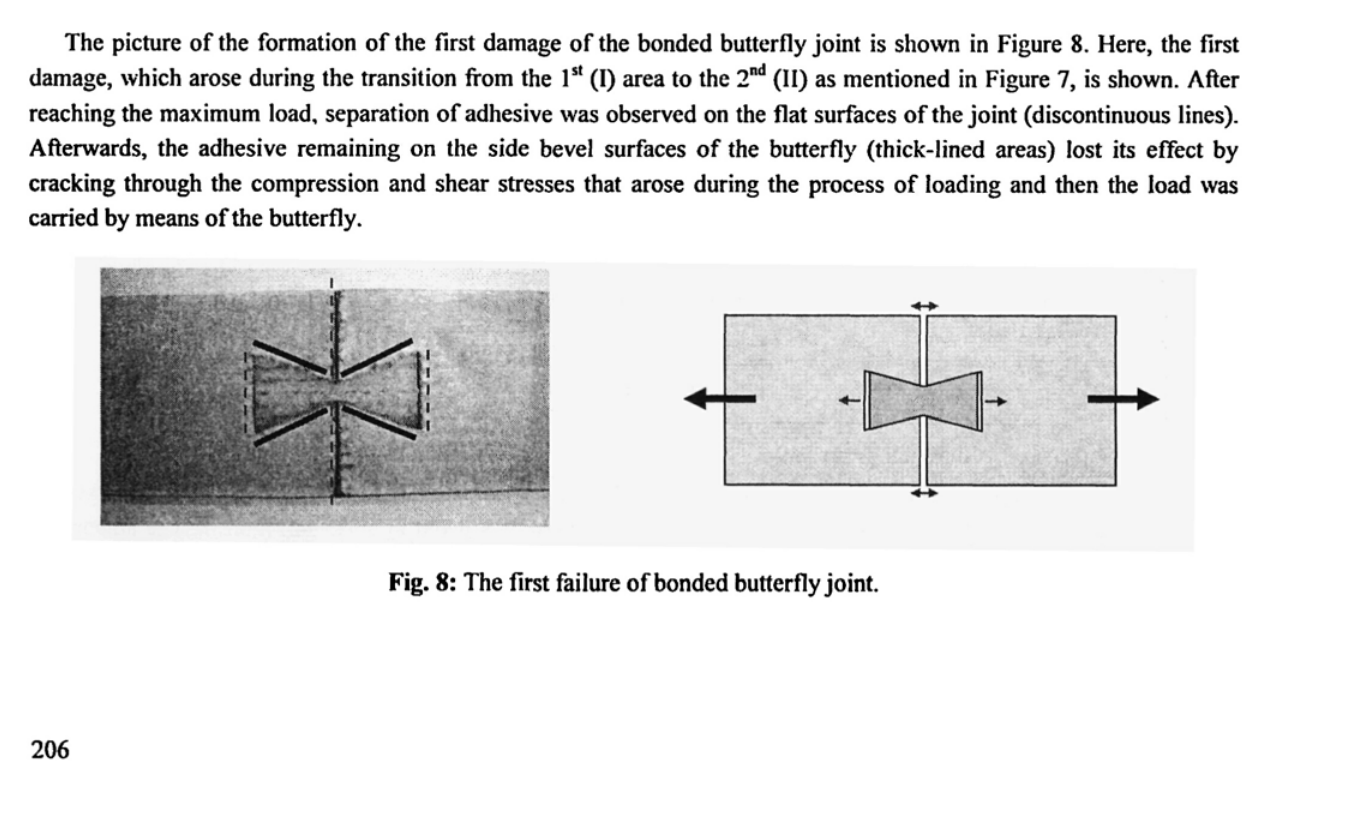
Fig. 7: The effect of I lysol 9464 adhesive on failure load-displacement.